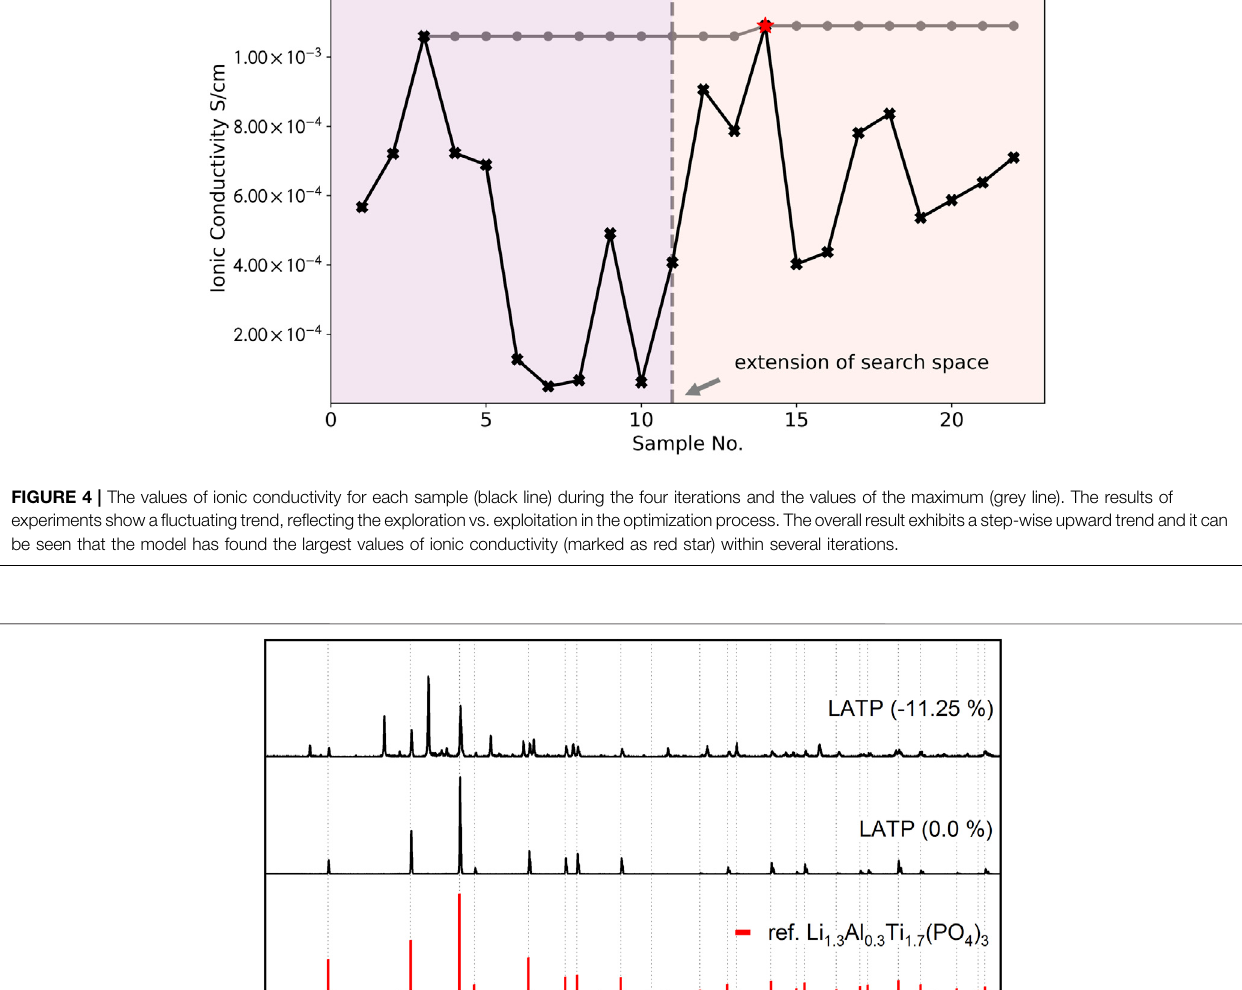
different iterations. Overall, results of predictions prove that our maximum ionic conductivity under different experimental condition where it has never been explored before. By using the Bayesian optimization model, it can help the experimentalist